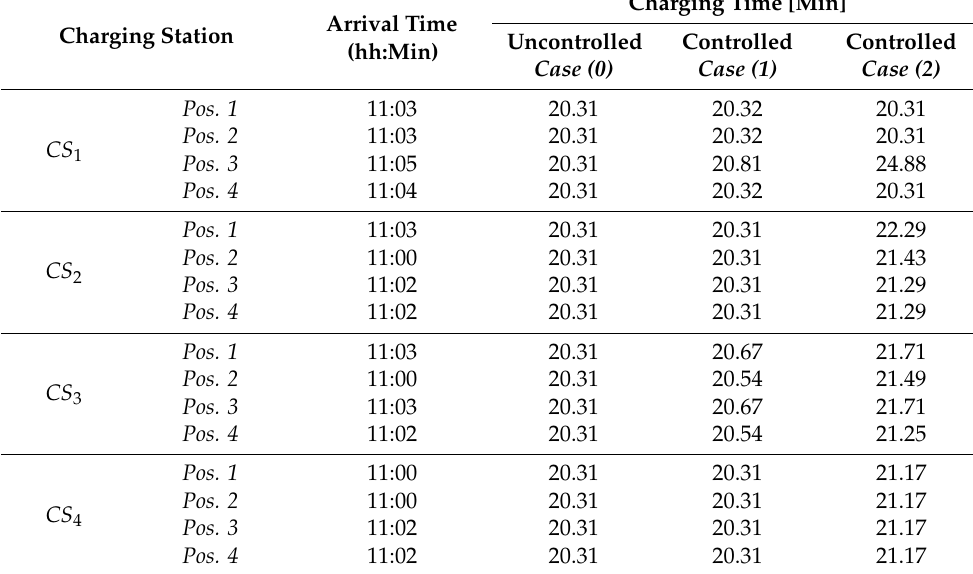
Table 3. Charging time of the